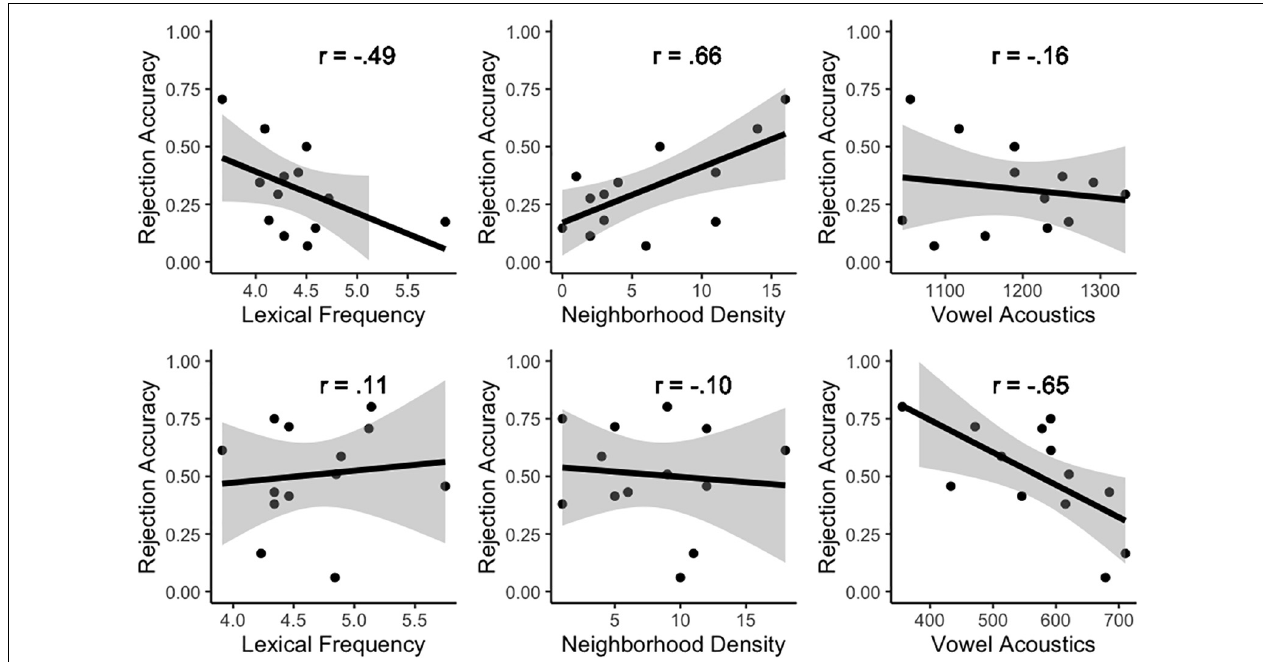
FIGURE 1 | Scatterplots of accuracy in nonword rejection for /æ/-nonwords (top row) and / ε /-nonwords (bottom row) as a function of lexical frequency (left), neighborhood density (center), and vowel acoustics (right). Regression lines and correlation coefficients (i.e., r ) are provided for illustration purposes.